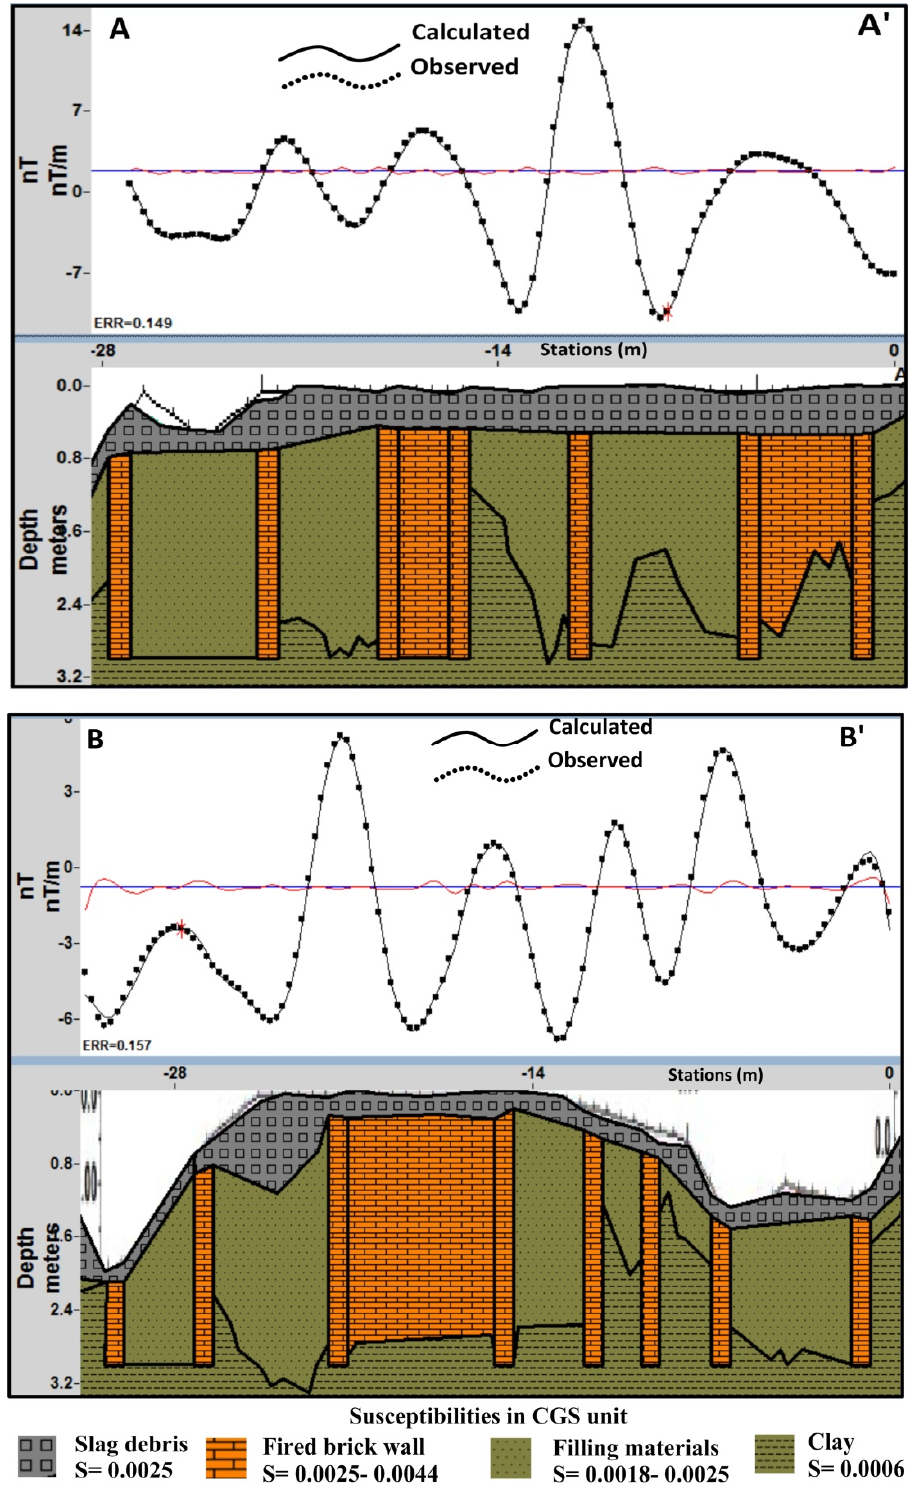
Figure 10. The 2.5-dimensional magnetic modeling along profiles: (A) AA ′ ; and (B) BB ′ .